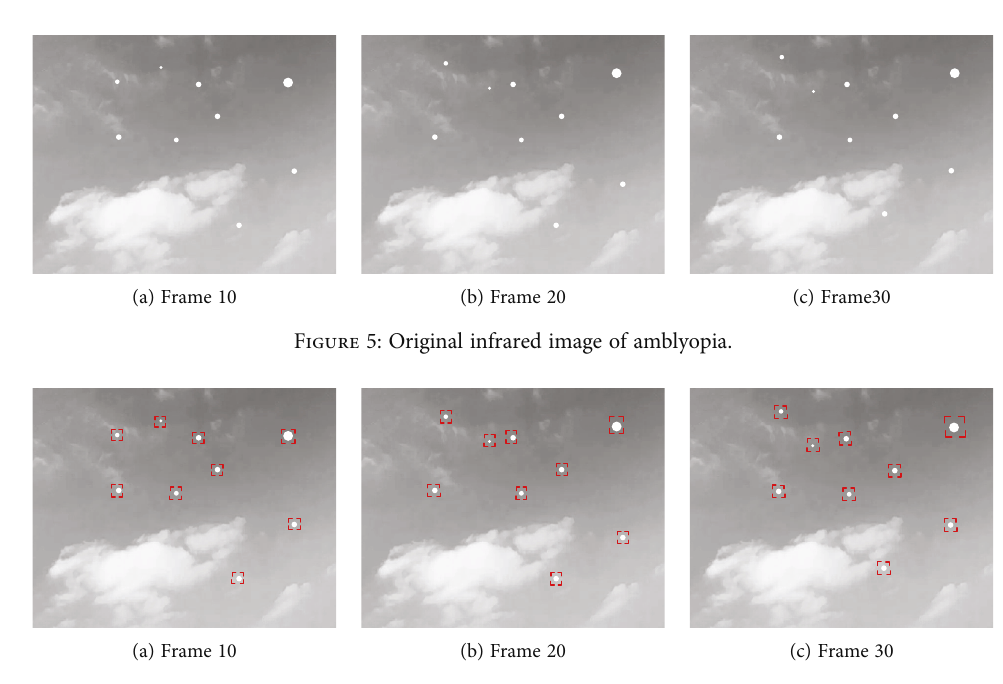
Figure 6: Three-frame image tracking e ff ect of weak small target tracking image sequence.